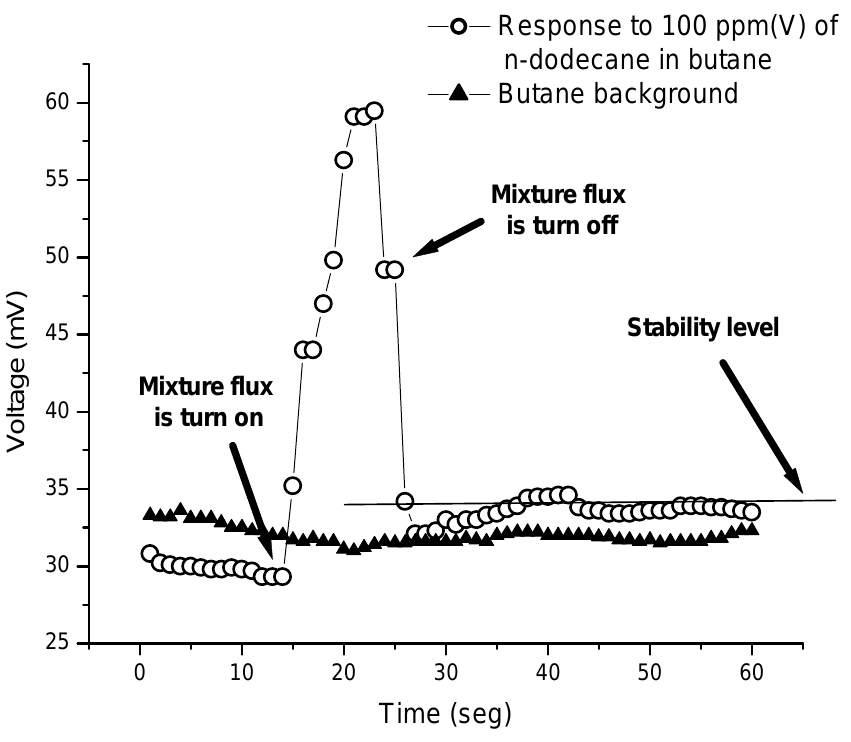
Figure 4. Response as a function of time of the sensing polyethylene layer. The selectivity to n-dodecane vapor can be observed to present a fast